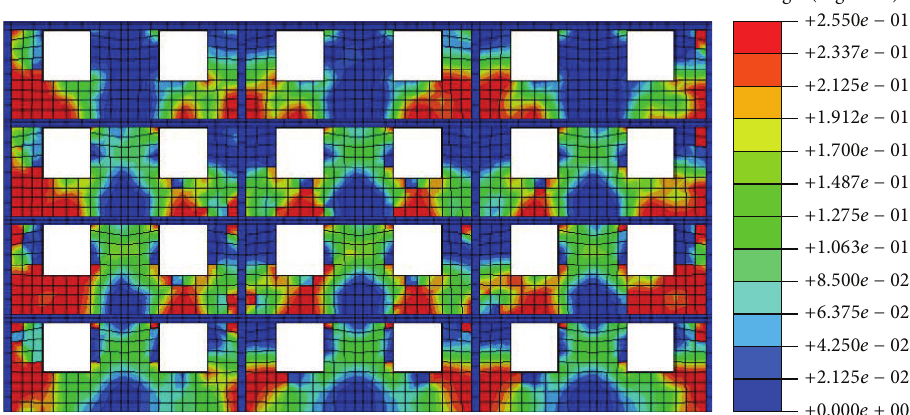
Figure 31: Tension crack damage cloud of model 3 under Lixian County ground